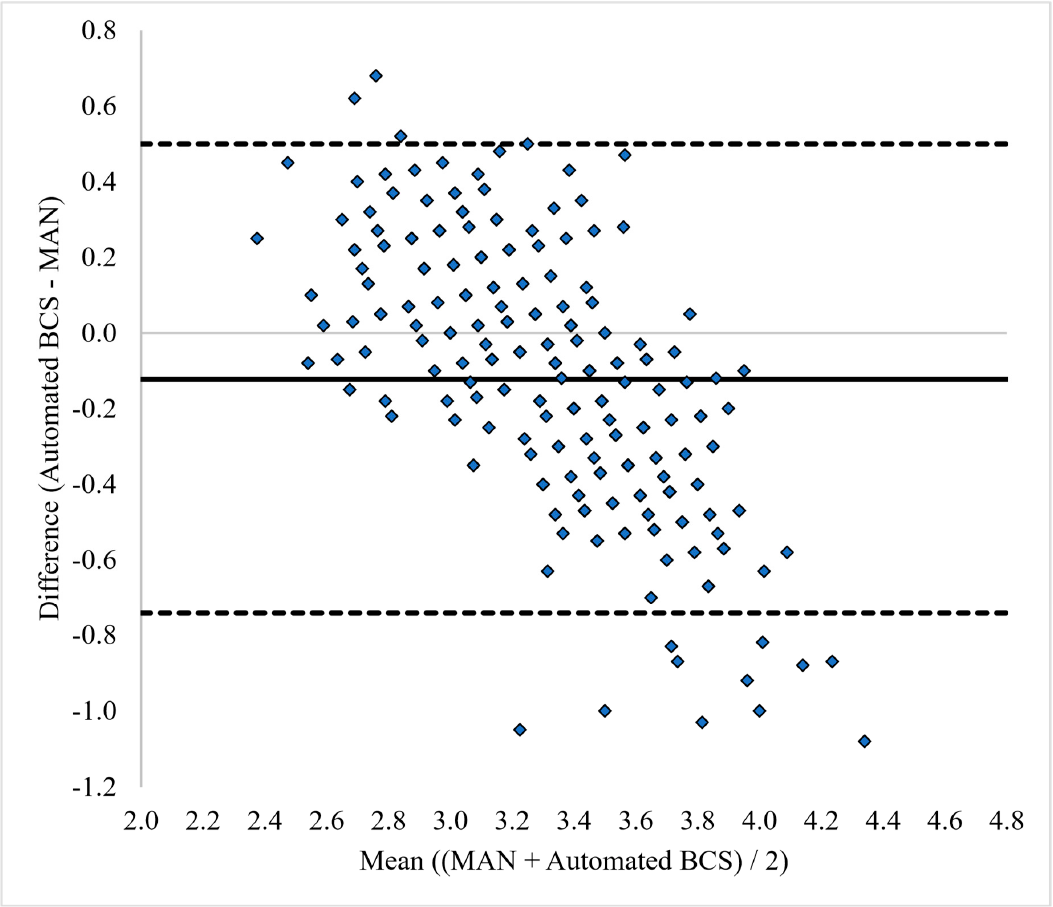
Figure 1. Bland–Altman plot of body condition scores (BCS) following [35] between manual average BCS scoring (MAN) and automated BCS scores. The solid line indicates the mean difference between the observation methodologies (Automated BCS – MAN) and the dotted lines represent 2 SD from the mean difference. The x-axis represents the range of the mean BCS for MAN and the automated BCS.